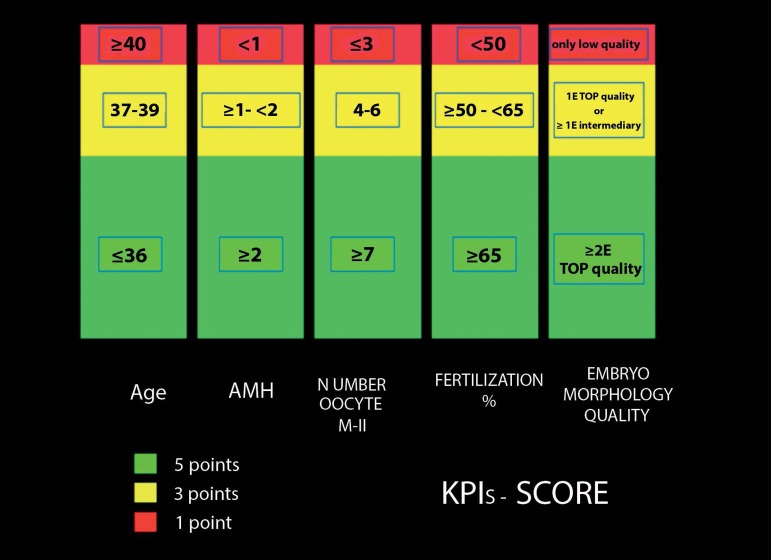
The KPIs- score system.